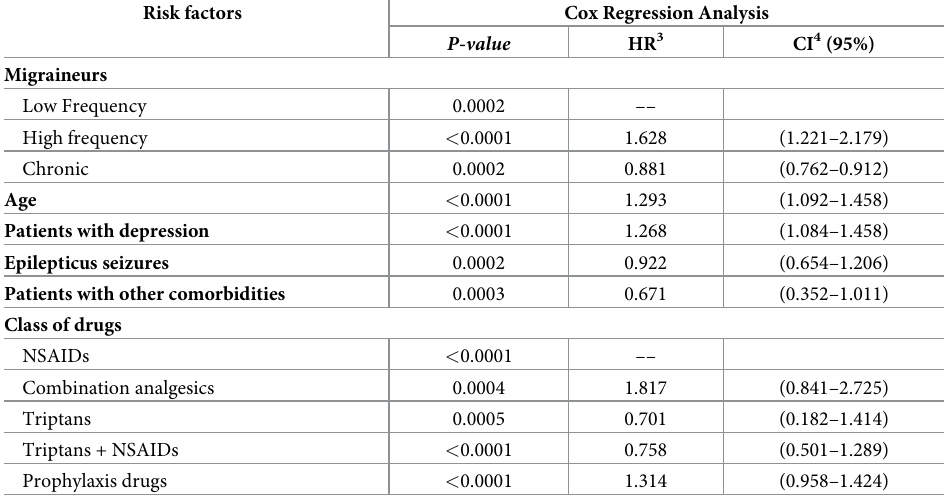
Table 6. Statistical analysis of migraineurs persistence towards treatment using chi-square and Cox proportional hazard regression